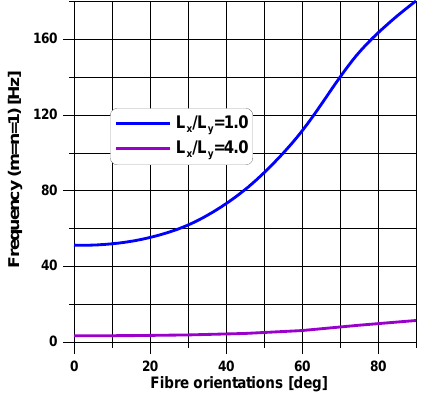
Aerospace 2018 , 5 , x FOR PEER REVIEW